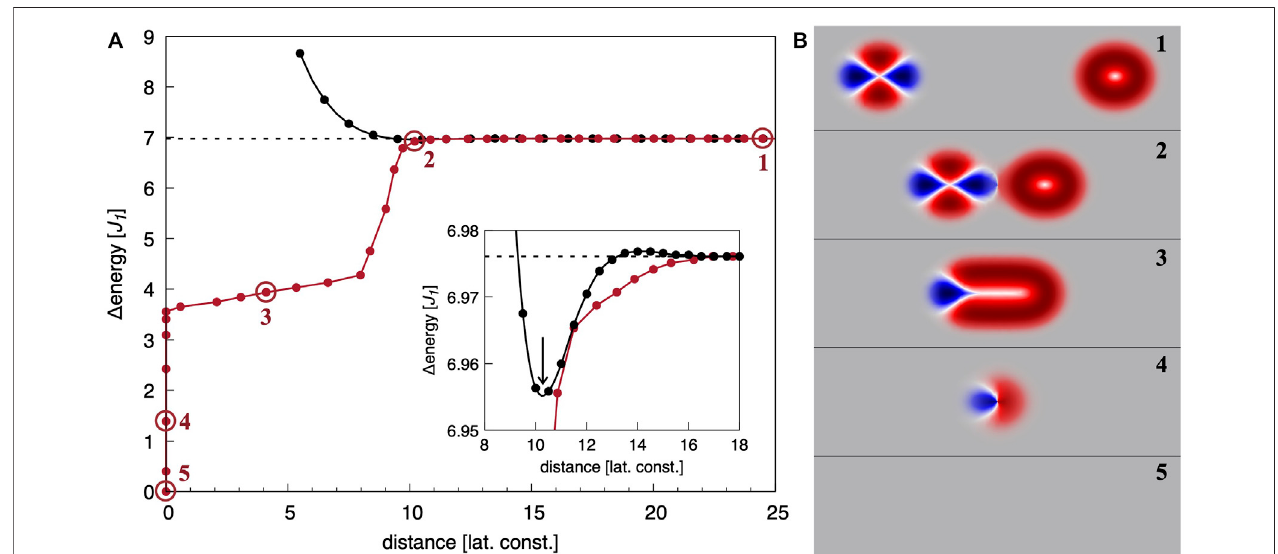
FIGURE3|(A) Energybarriersforapproaching(anti-)skyrmionsalongthe x -direction.TheMEPforthefusionofaskyrmionandanantiskyrmionisshowninredand thedistancedependentenergyfortwoequivalentparticles(eitherskyrmionsorantiskyrmions)isshowninblack.Themagnetictexturesofexemplaryintermediatestates along the MEP are shown in (B) . The corresponding points are highlighted by circles in (A) and labeled accordingly. The color code in (B) indicates the chirality of the particles. Red and blue represent Néel-type chirality (of opposite sign) while white highlights regions with Bloch-type chirality. State 5 indicates the ferromagnetic ground state, taken as energy zero reference and illustrated as grey background in (B) . Distances are measured between the cores of the particles.